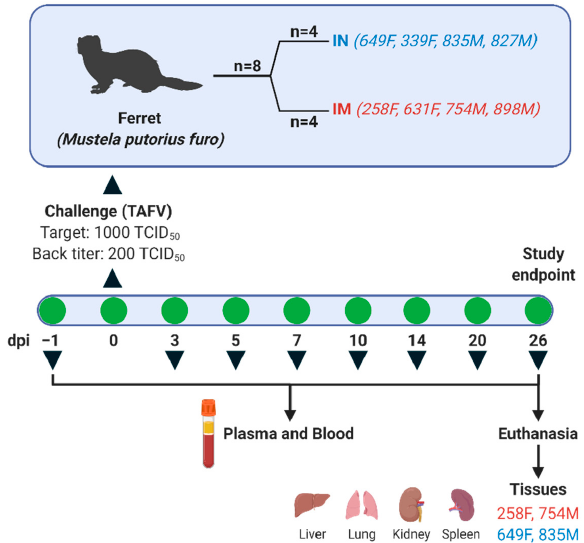
Figure 1. Experimental Design. Ferrets were divided into two groups ( n = 4/group) containing equal numbers of males and females. Animals were challenged intramuscularly (IM) or intranasally (IN) with Taï Forest virus (TAFV) at a target dose of 1000 TCID 50 . Whole blood and plasma were collected on − 1, 3, 5, 7, 10, 14, 20, and 26 days-post infection (dpi) for subsequent viral RNA, hematology, complete blood count, and IgG analysis. Tissues (liver, lung, spleen, and kidney) were harvested at study end-point from animals 258F, 754M, 649F, and 835M for viral RNA analysis.